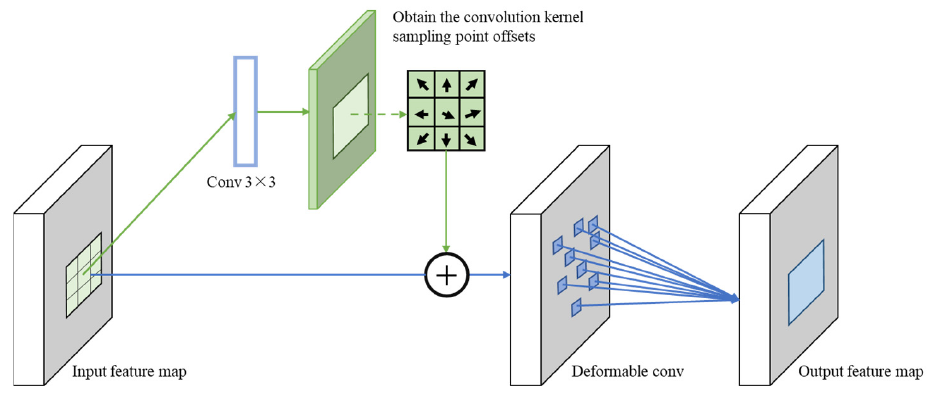
Figure 9. DCN diagram with 3 × 3 convolution kernel.